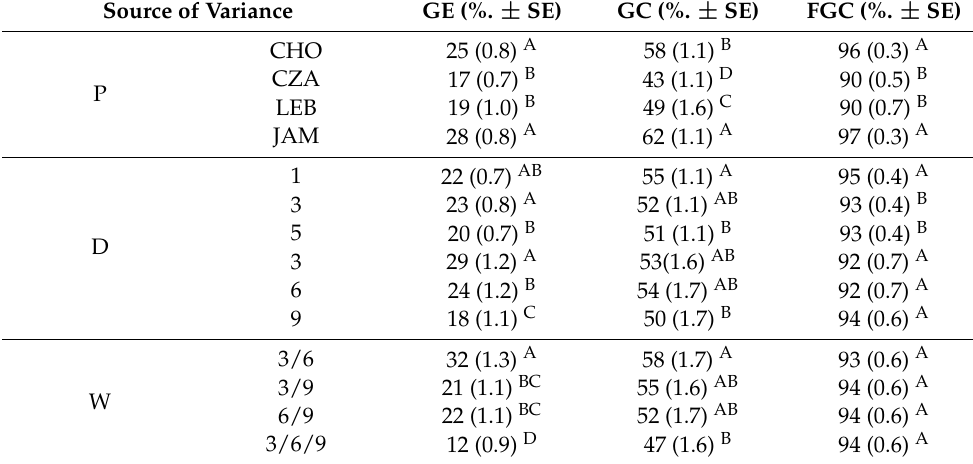
Table 1. Germination energy (GE), germination capacity (GC) and final germination capacity